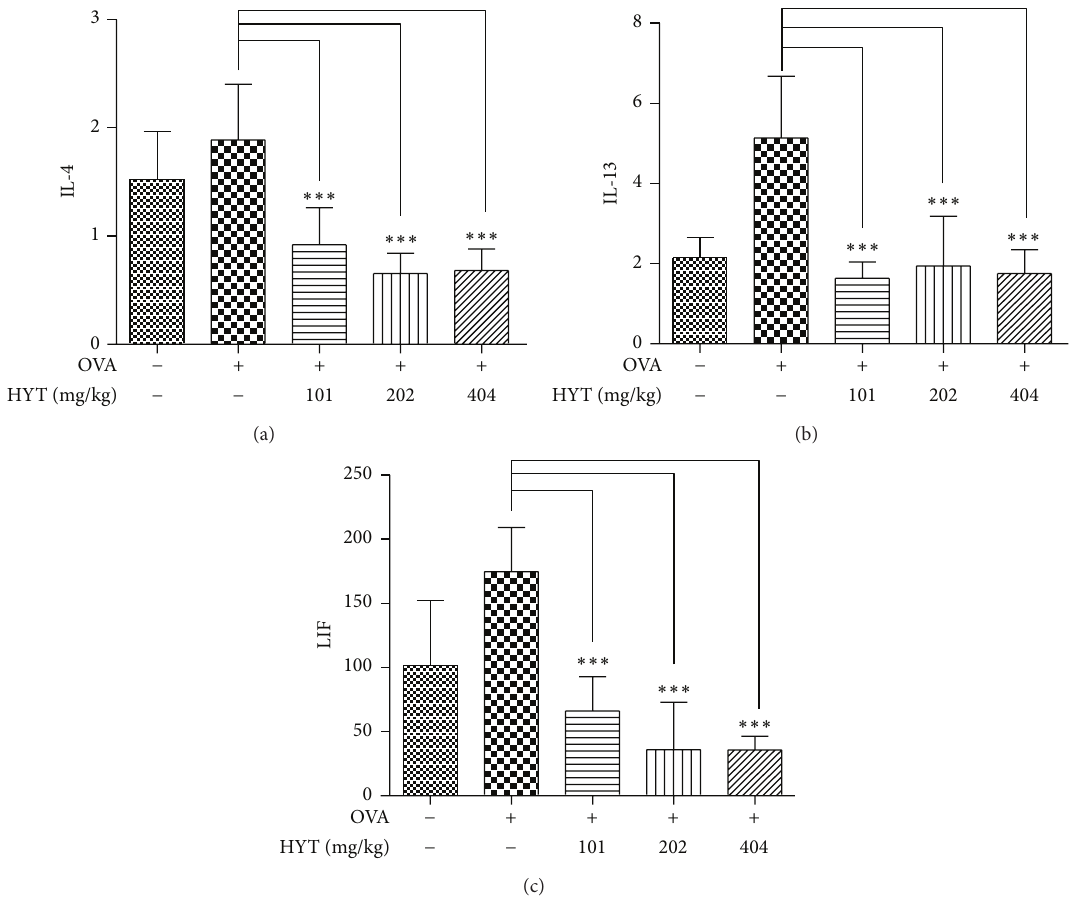
Figure 6: HYT reduced the levels of cytokines in the serum. The cytokines levels were measured by multiplex cytokine assay. Data are presented as mean ± SEM. ∗ 𝑃 < 0.05 , ∗∗ 𝑃 < 0.01 , and ∗∗∗ 𝑃 < 0.001